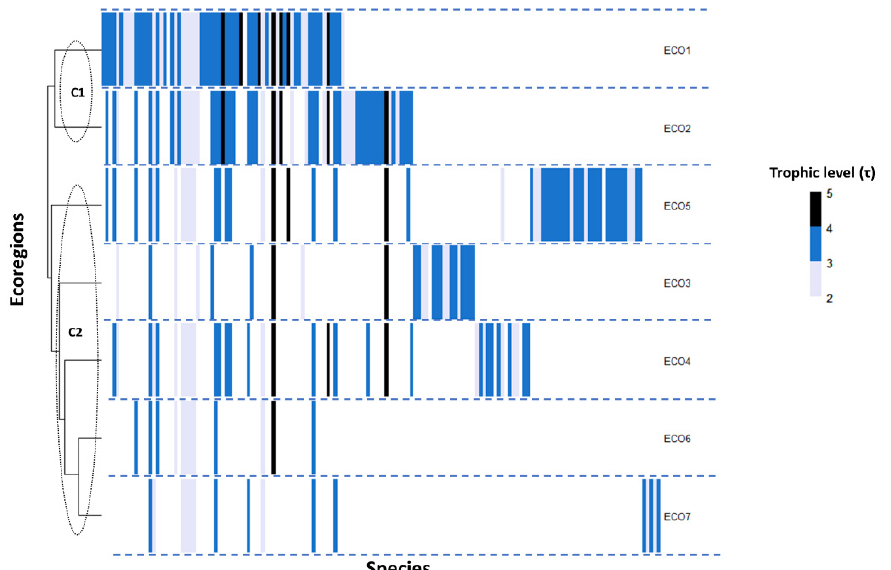
Figure 1. Heatmap analysis of the freshwater fish species ( N = 157) trophic level ( τ < 3: gray; 3 < τ < 4: blue; τ > 4: black) in the hierarchical clustered Greek ecoregions. Each column represents a species, and each row represents the ecoregion of presence. Ecoregions are according to Zogaris and Economou [35] as follows: ECO1: Thrace, ECO2: Macedonia-Thessaly, ECO3: Southeastern Adriatic, ECO4: Western Aegean, ECO5: Ionian, ECO6: Crete, ECO7: Eastern Aegean.